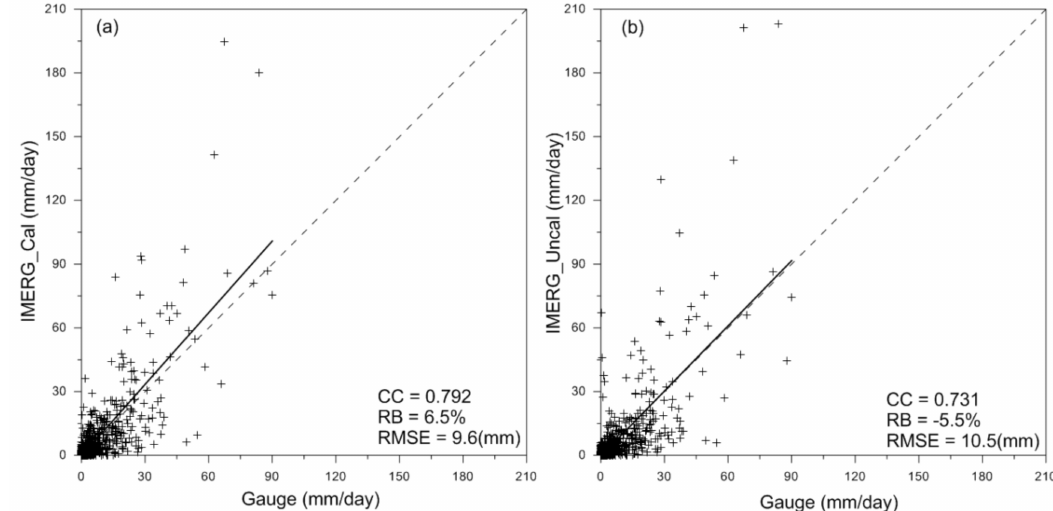
Figure 5. Scatter plots of daily basin-average precipitation between gauges and the IMERG (IMERG_Cal ( a ) and IMERG_Uncal ( b )) over the Nanliu River basin, from April 2014 to December